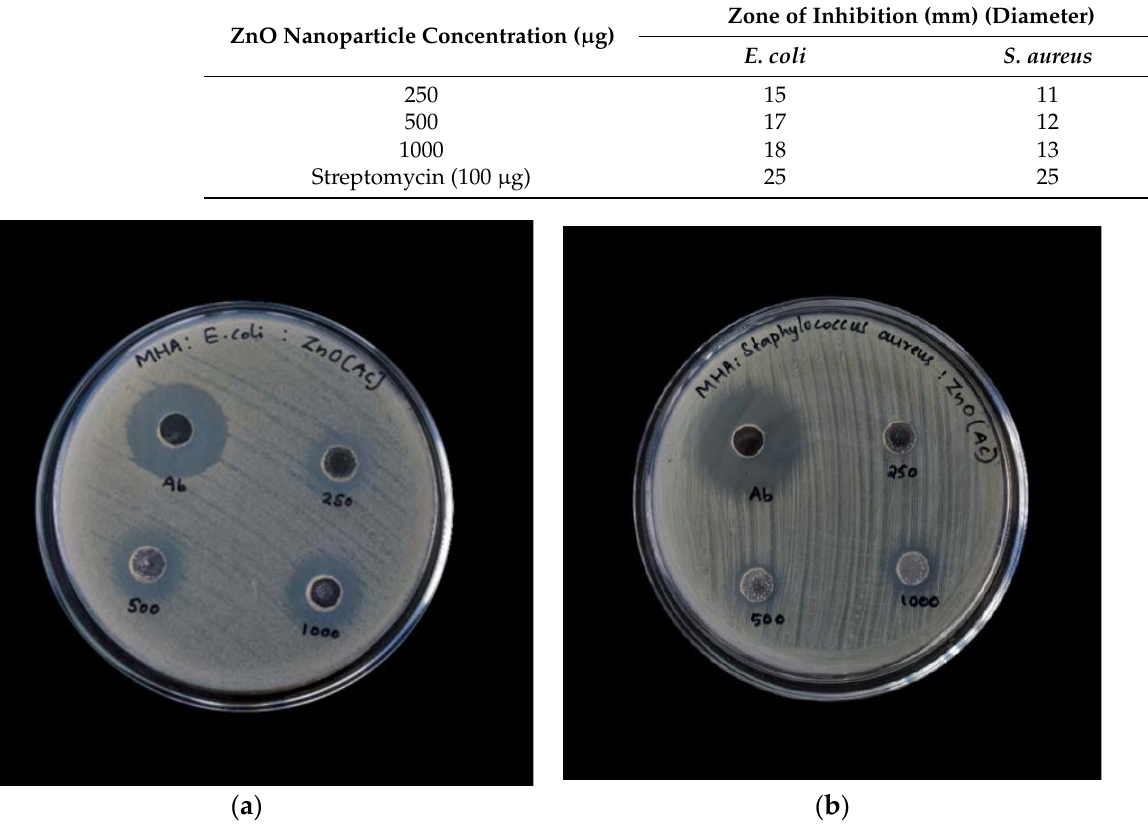
Figure 10. The green synthesized ZnO nanoparticles using Acacia caesia (L.) Willd. bark extract exhibited strong antibacterial activity against both Gram-negative ( E. coli ) and Gram-positive ( S. aureus ) bacteria strains. The 1000 µ g/mL concentration of ZnO nanopar- ticles showed a maximum inhibition zone in both strains. Various studies reported that green synthesized ZnO nanoparticles show high bactericidal activity in both strains [85–87]. Table 3. Antibacterial activity of ZnO nanoparticles . Table 3. Antibacterial activity of ZnO nanoparticles. Zone of Inhibition (mm) (Diameter) ZnO Nanoparticle Concentration ( µ g)